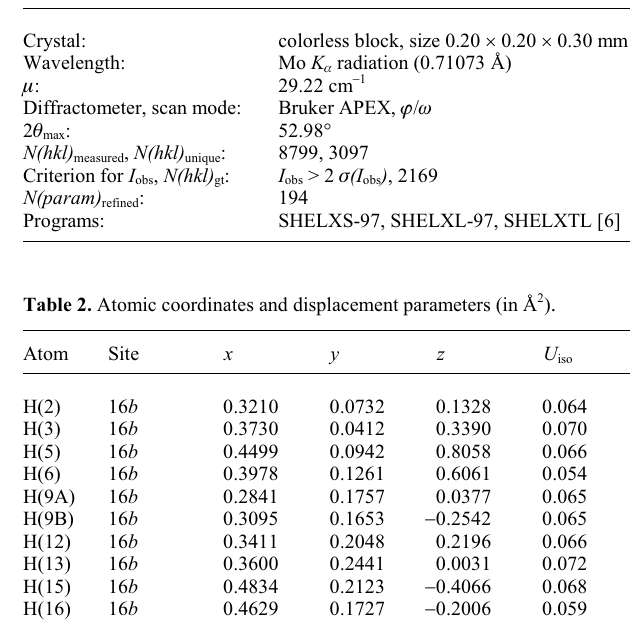
Table 1. Data collection and handling.